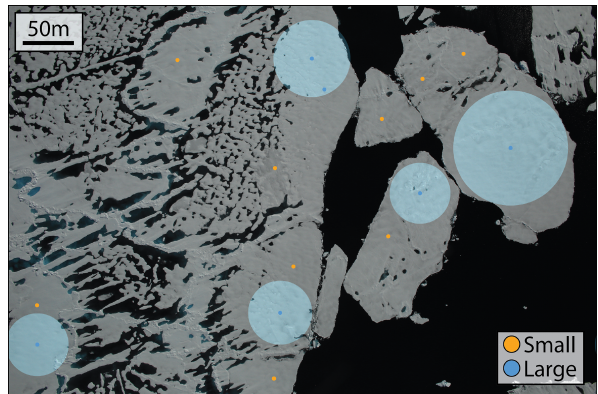
Figure 3. Example of the pond-free region detection. Pond-free re- gions are marked by small colored dots. Blue dots indicate the larger regions and orange dots indicate the smaller ones. Translucent blue circles are drawn with a radius equal to the size of the detected large regions. Blue dots without a translucent circle were merged with a neighboring